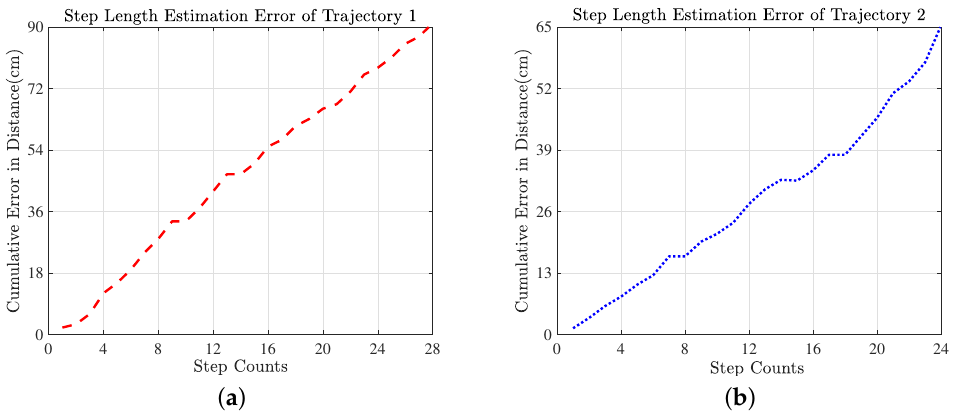
Figure 13. Average cumulative error of step length of the participants during ( a ) trajectory 1 and ( b ) trajectory